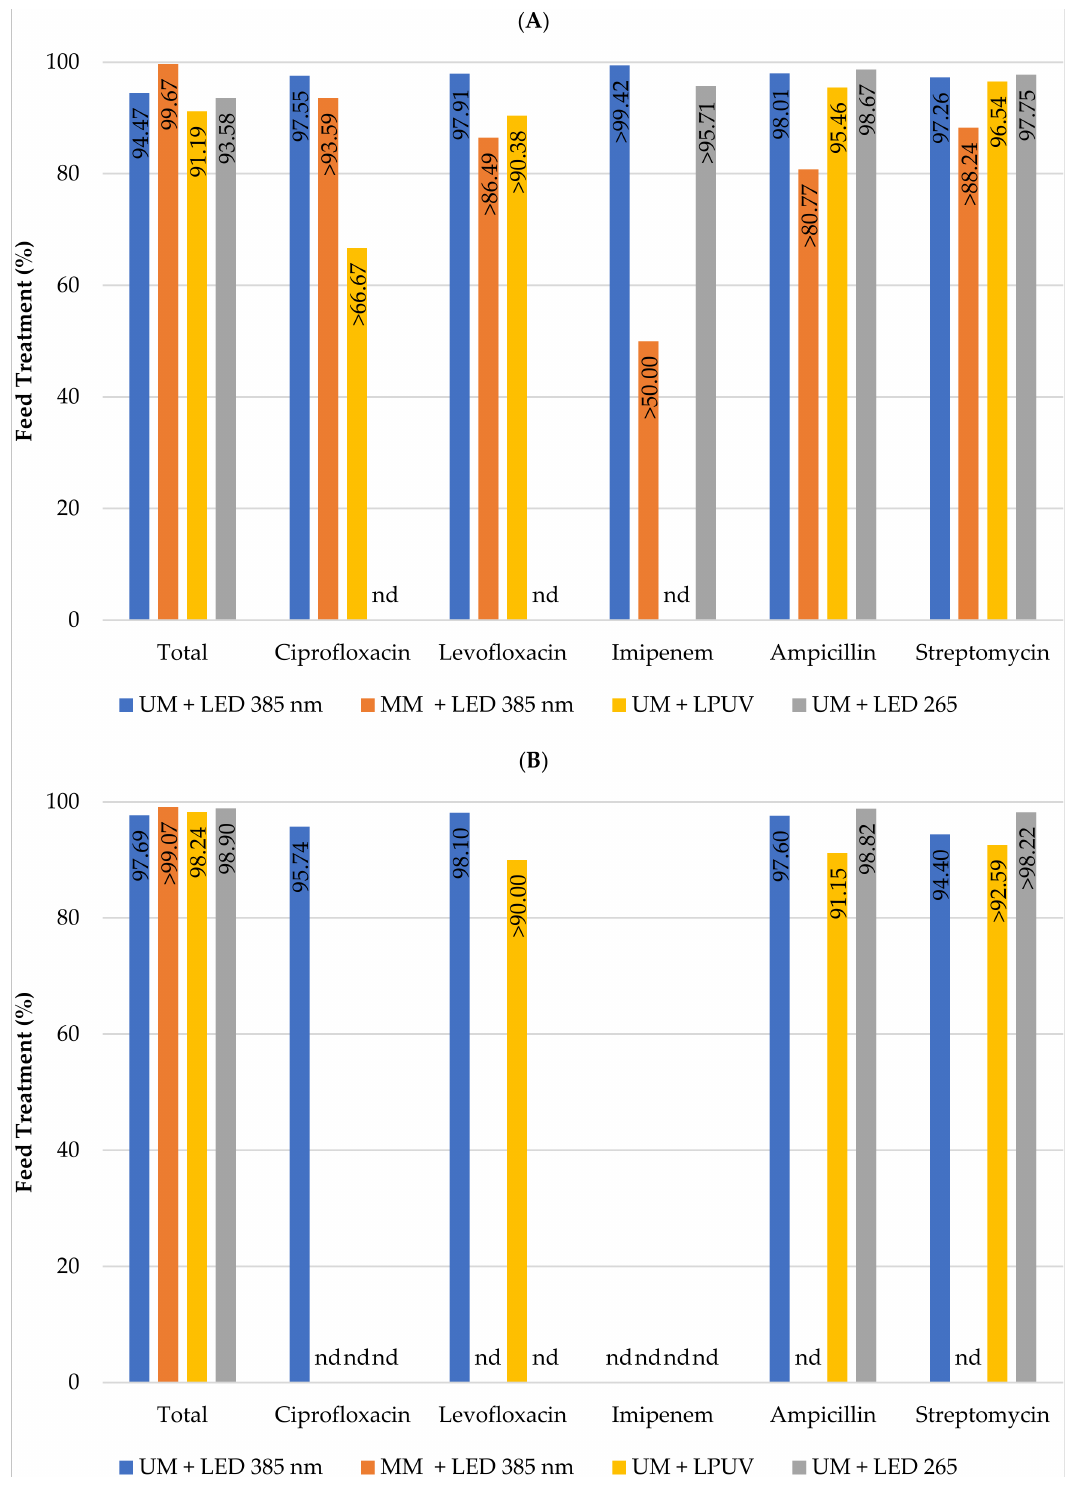
Figure 5. Feed treatment of total coliforms and total coliforms resistant to various antibiotics ( A ) as well as Escherichia coli and antibiotic-resistant Escherichia coli ( B ) using the hybrid reactor combined treatment. The antibiotics tested were ciprofloxacin, levofloxacin, imipenem, ampicillin, and strepto- mycin. Columns marked “nd” indicate that the target bacteria were not detected in the untreated surface water